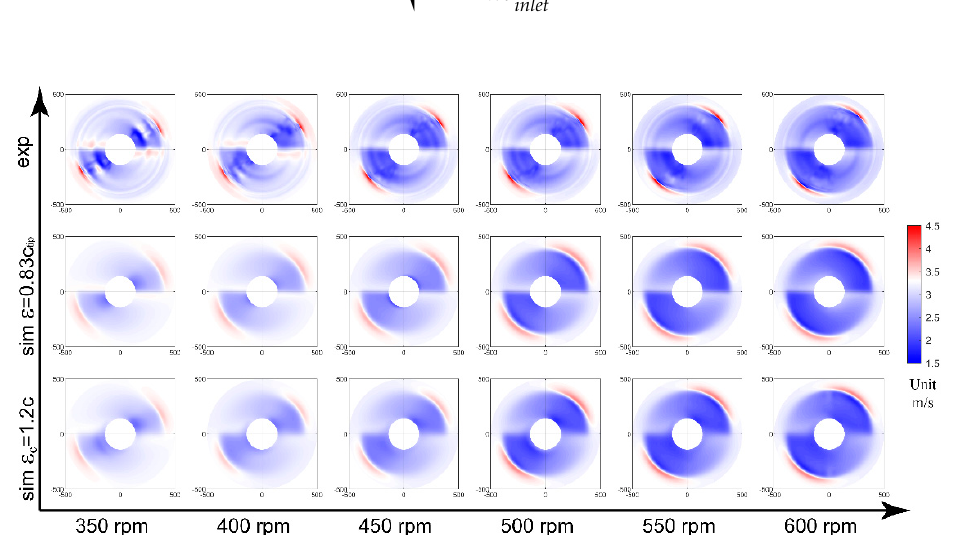
Figure 16. The velocity magnitude contour of the plane (45 mm behind the rotor) perpendicular to the main flow direction. The origin is the main shaft location and the data area is a ring with outer radius of 500 mm and inner radius of 140 mm. The first row represents the experiment result, the second row represent the result of standard kernel and the third row represents the result of anisotropic kernel.